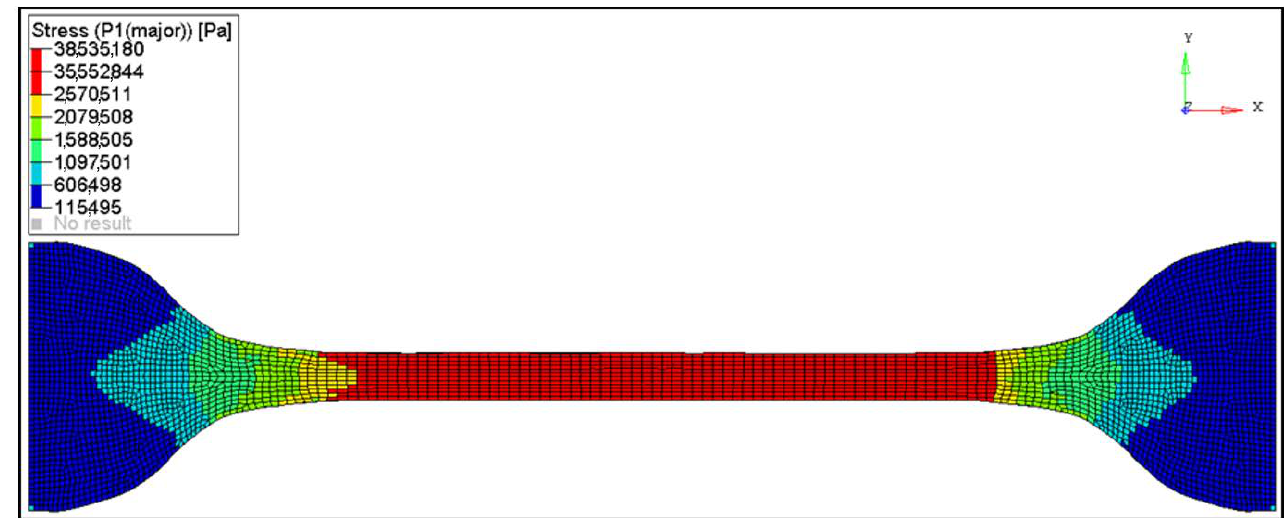
Figure 4. PVB tensile test—FEM at t = − 30 ◦